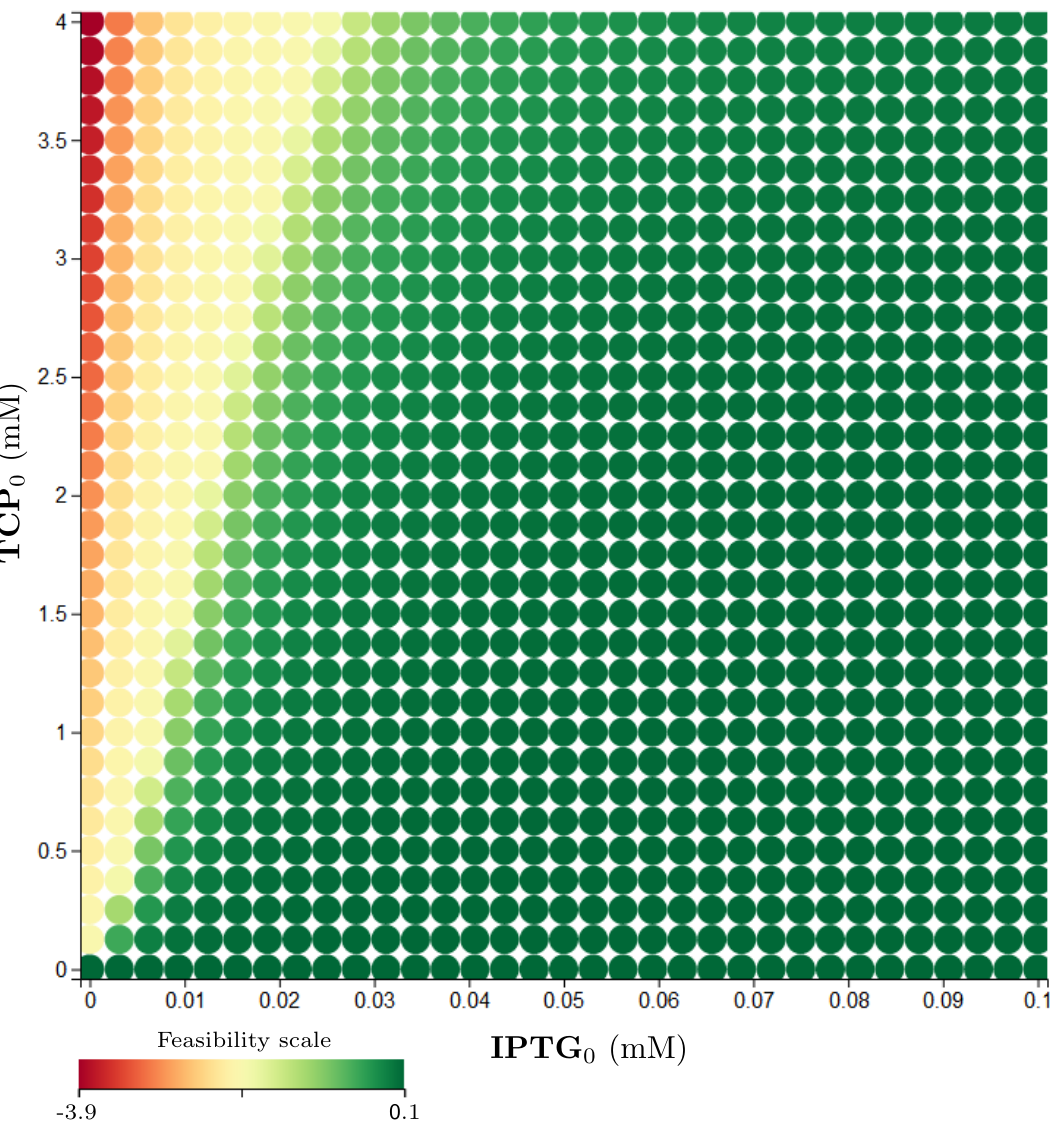
Figure 15. Results of robustness monitoring for Property 6 concerning TCP 0 . The Figure Shows a two-dimensional plot with various coloured circles pointing by their centre to the particular setting of the plotted parameters (or variables). Initial values of variables and considered parameters (if not displayed in any axis) are: Bact 0 = 0.487 (g/L); GLY 0 , ( R )-DCP 0 , ( S )-DCP 0 , ECH 0 , CPD 0 , GDL 0 , TCP 0 = 0 (mM); γ Bact = 0.0022 ( h − 1 ) . All the constants can be found in Figure 11. The shades of green colour imply a feasibility of the particular property in the particular initial setting while the shades of red imply a violation of the property—the darker the tone, the stronger the feasibility/violation. At the bottom of the plot, there is the feasibility scale mapped to real values. The plot represents a single layer of the entire parameter